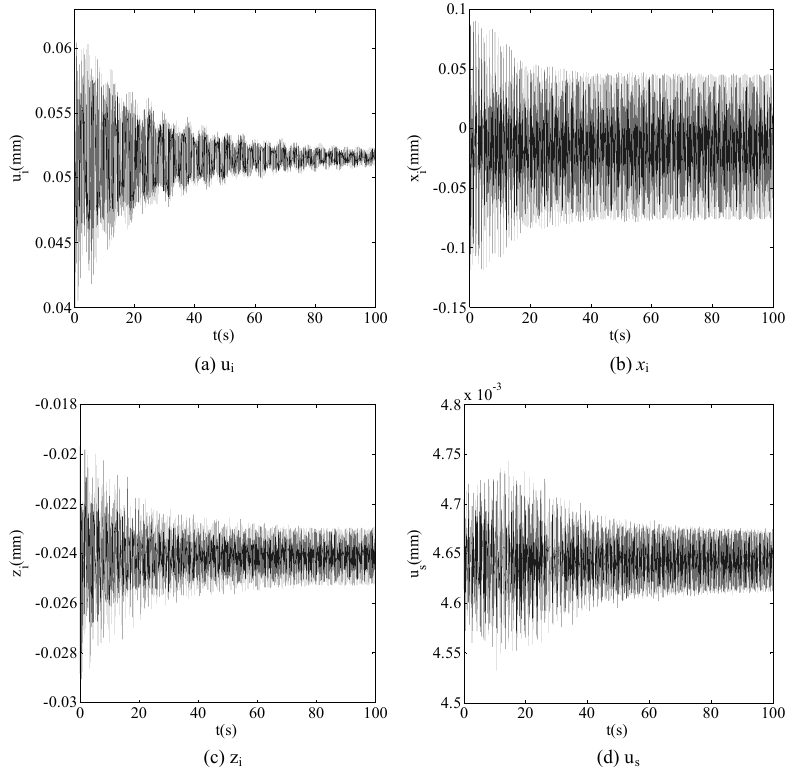
Fig. 6. The forced responses of the drive system to the dynamic eccentric center ( ω = 1200 rad/s). characteristics of the rotational modes. Meanwhile, the vibration center shift of the drive system occurs which is caused by the average eccentric center. The vibration of the stator has more obvious effect on the dynamic behavior of the drive system. So, the eccentric center should be avoided and its exciting frequency should be far from the natural frequencies of the rotational